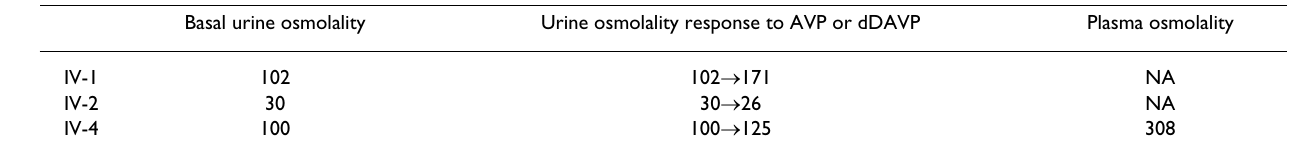
Table 1: basal urine osmolality and plasma